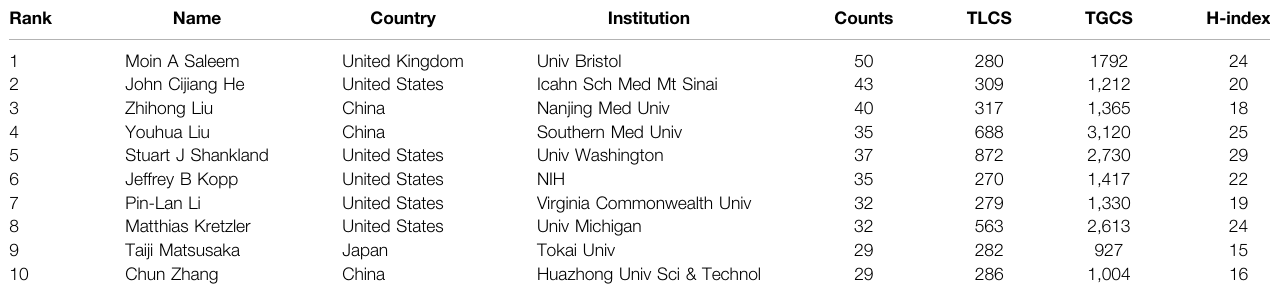
TABLE 3 | The top 10 most productive authors in podocyte injury research.